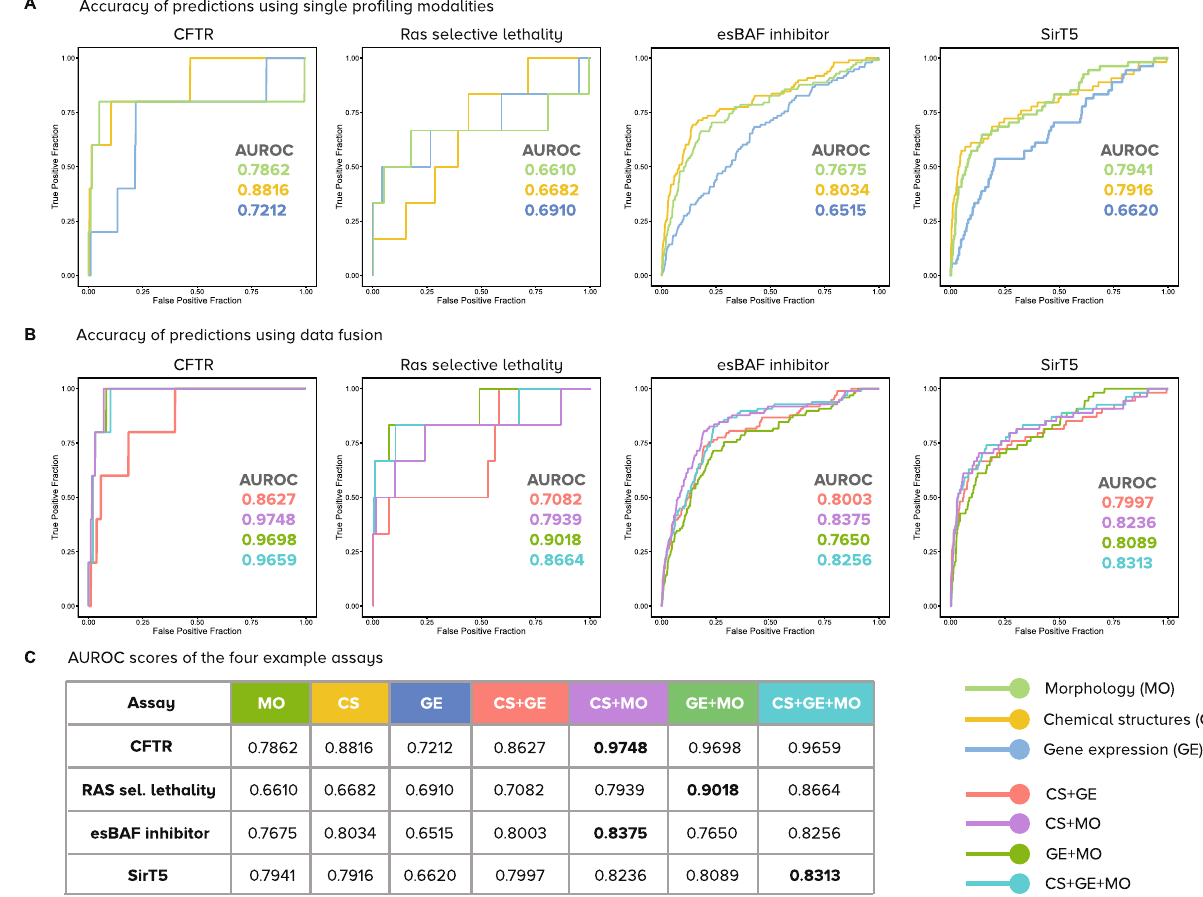
Fig. 4 | Prediction performance of example assays where data fusion success- fully improves prediction accuracy. Not all assays bene fi t from data fusion: see Fig. 3 for summary statistics of all assays. The plots are Receiver Operating Char- acteristic (ROC) curvesand the area under the curve (AUROC) isreported for each modality with the corresponding color. A Four example assays from left to right: Cystic fi brosis transmembrane conductance regulator CFTR (cell-based), Ras